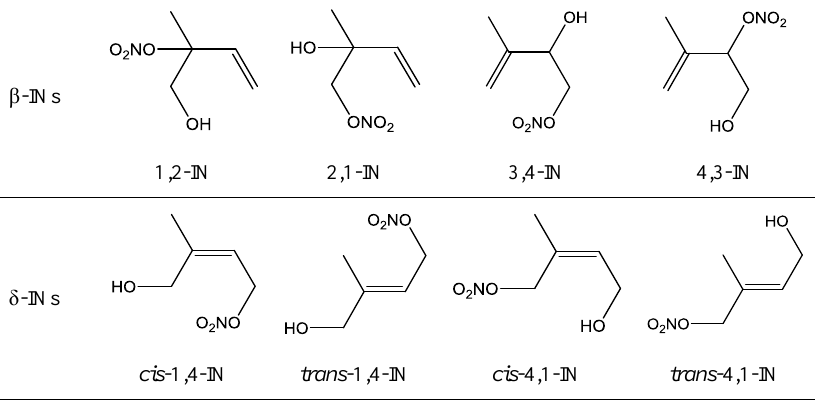
Table 2. Initial conditions for IN yield experiments. 938